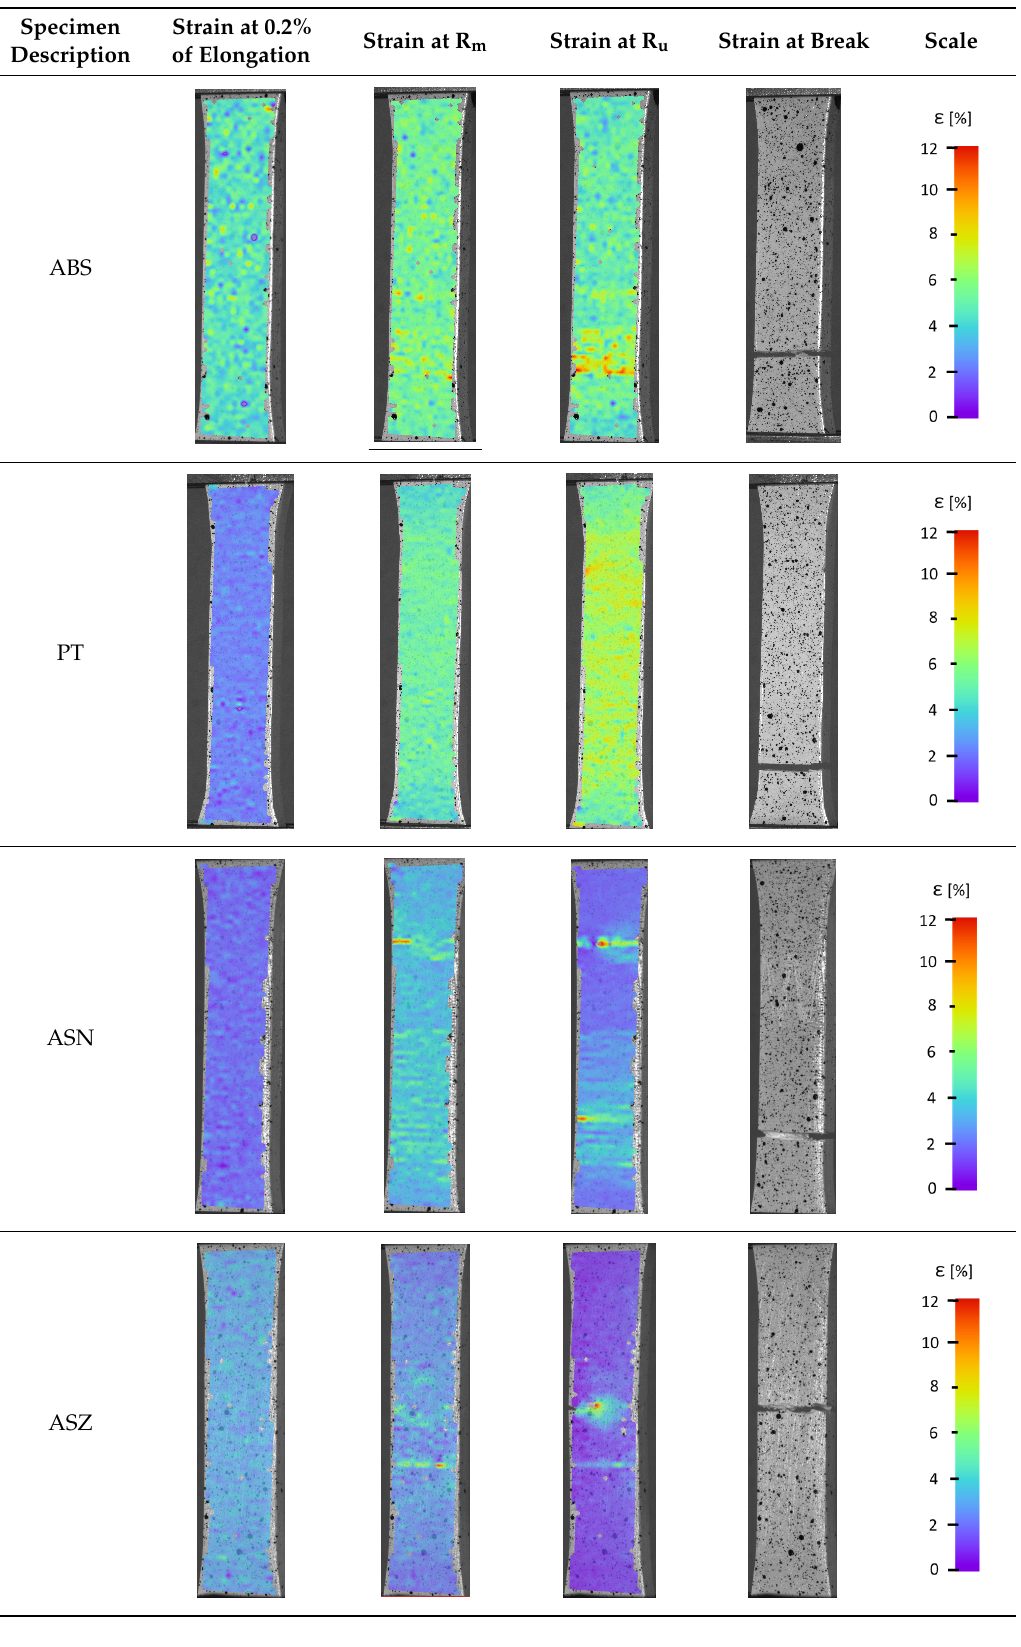
Table 4. DIC strain distribution maps of the specimens during tensile tests.